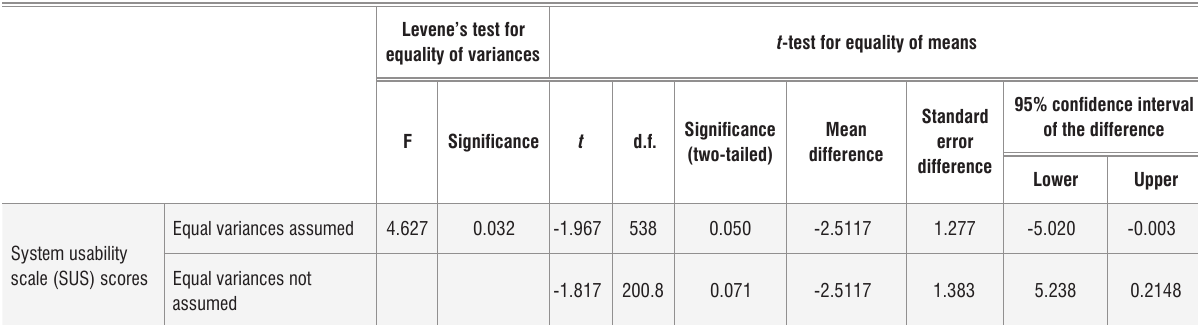
System usability scale (SUS) scores